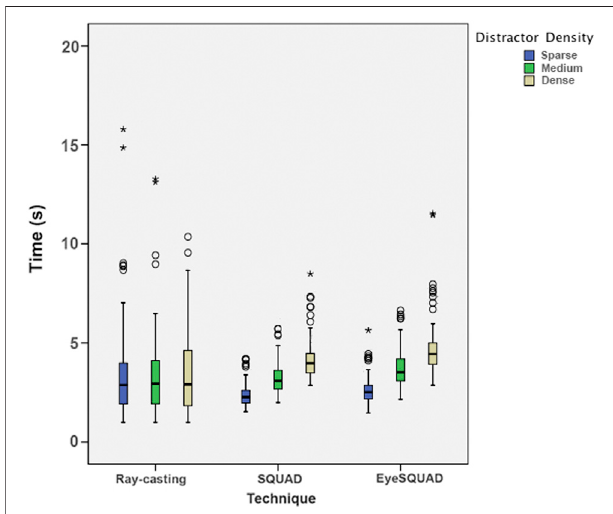
FIGURE 9 | Interaction between technique and distractor density on